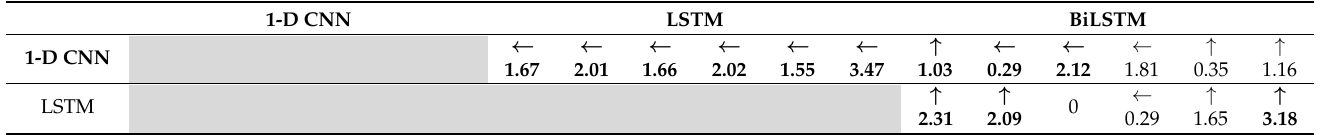
Table A4. Z scores of DL algorithms on cancer stage classification. (Illustrations by the